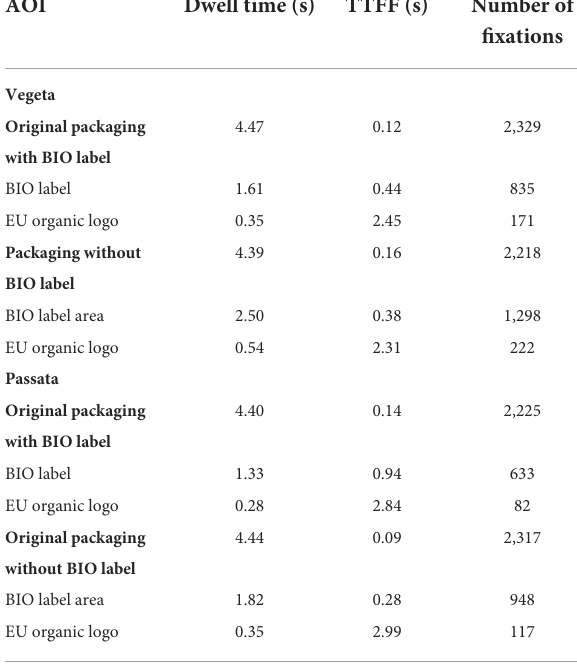
When assessing the difference in visual attention for